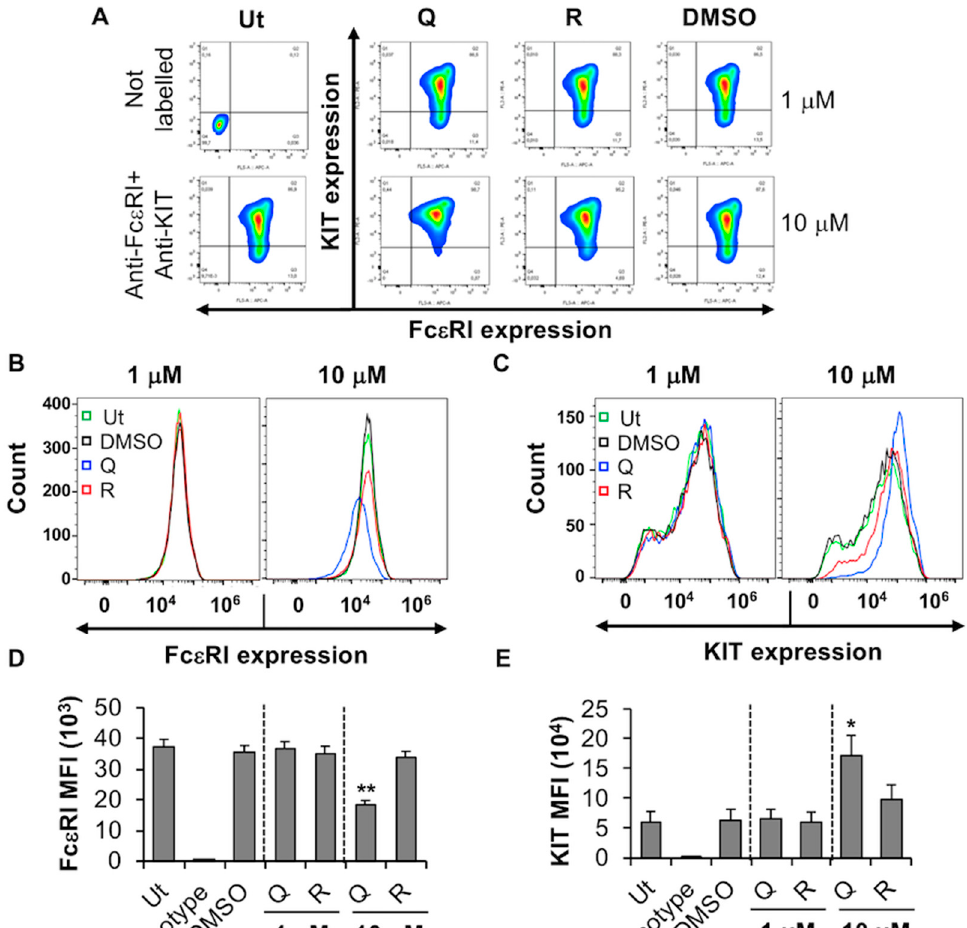
Figure 1. Effects of resveratrol and quercetin on Fc ε RI and KIT expression by MC/9. ( A ) MC/9 were treated with 1 or 10 µM quercetin (Q), resveratrol (R) or DMSO for 24 h followed by flow cytometry analysis. Ut represents untreated MC/9. Fc ε RI versus KIT expression contour plots were generated relative to the untreated unstained sample shown on the left-hand side panel. ( B , C ) Histogram overlay showing Fc ε RI and KIT expression by MC/9 treated with 1 or 10 µ M Q, R or DMSO as in A. ( D , E ) Mean fluorescence intensity (MFI) of Fc ε RI and KIT expression by MC/9 treated as in A. n = 6. p values < 0.05 (*) and < 0.01 (**) are relative to DMSO control.